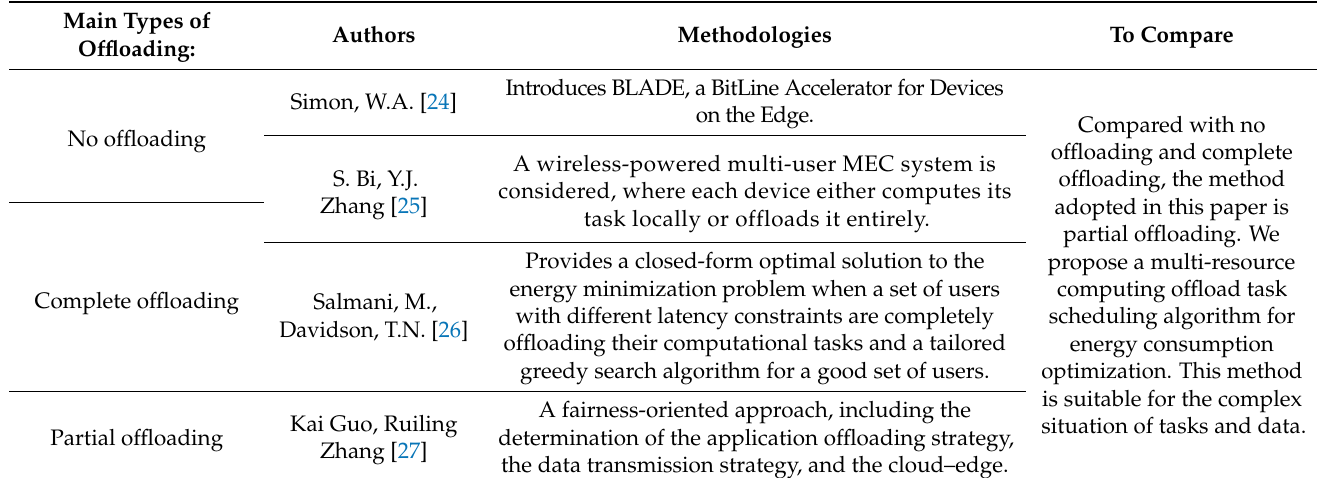
Table 1. Research of related papers.